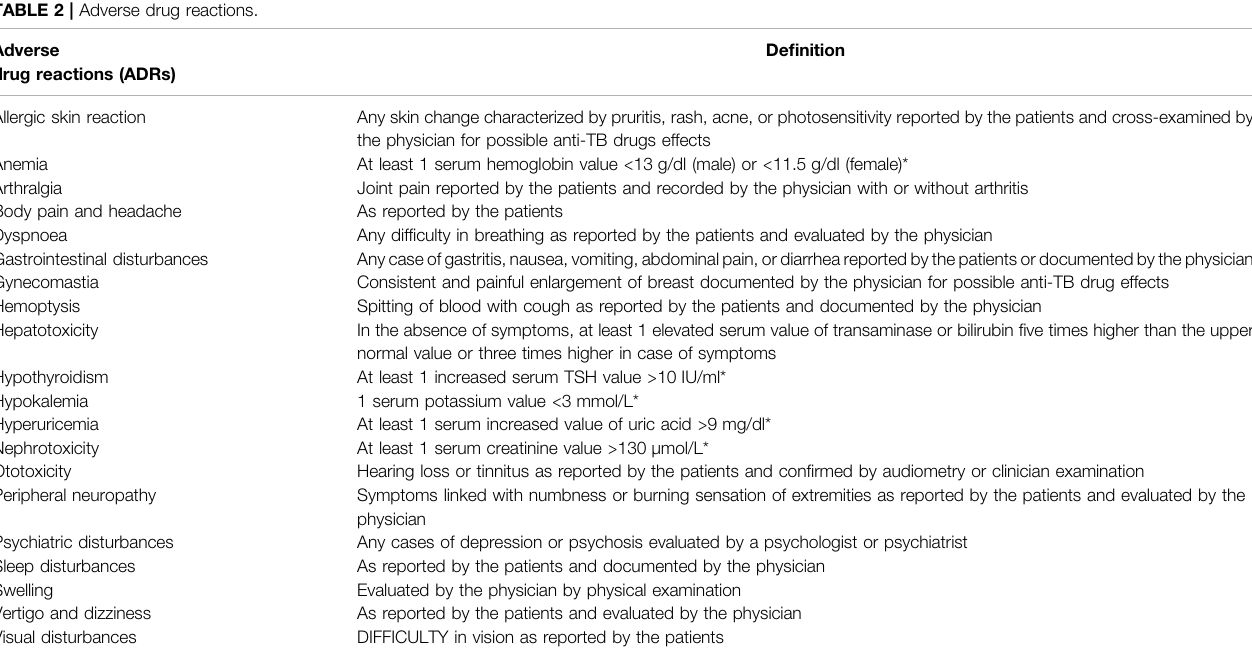
TABLE 2 | Adverse drug